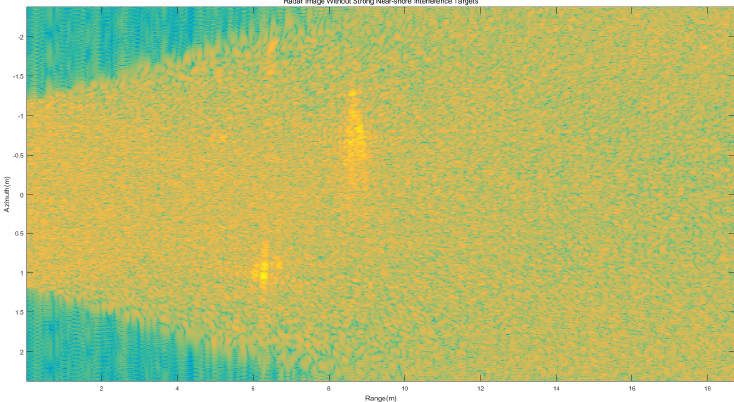
Figure 9. Static Kelvin wake radar image without strong near-shore interference targets.